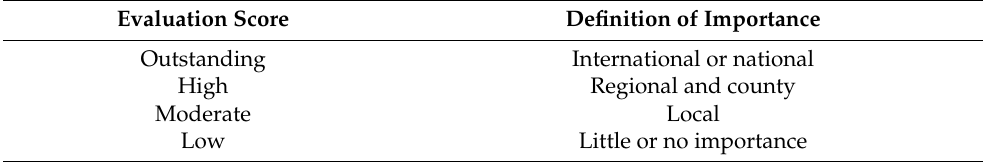
Table 2. The importance definitions of the LANDMAP evaluation